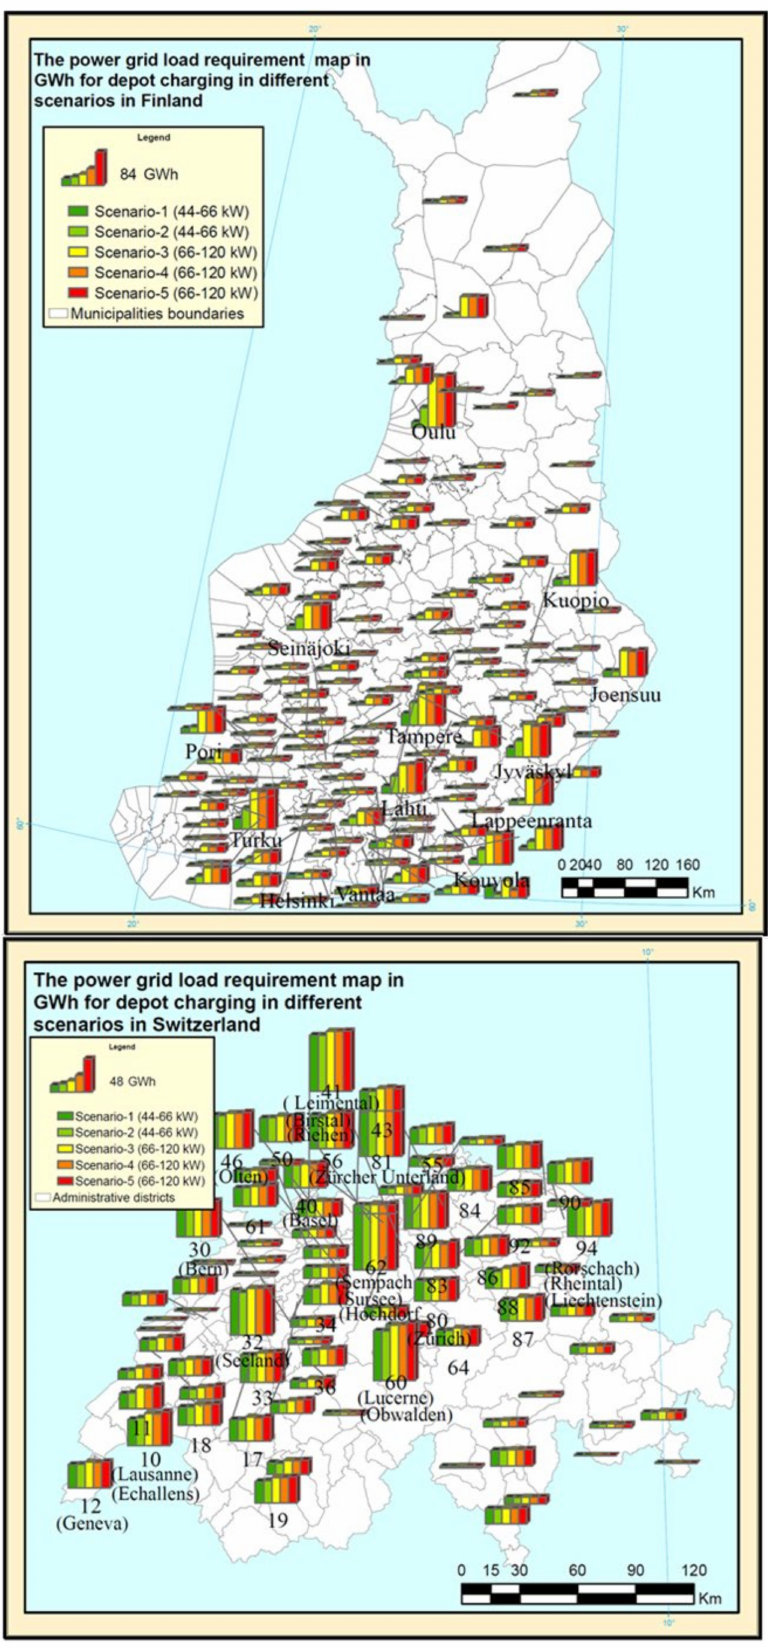
Figure 7. Annual power grid load requirement maps for depot charging facilities in different O–D zones in Finland and